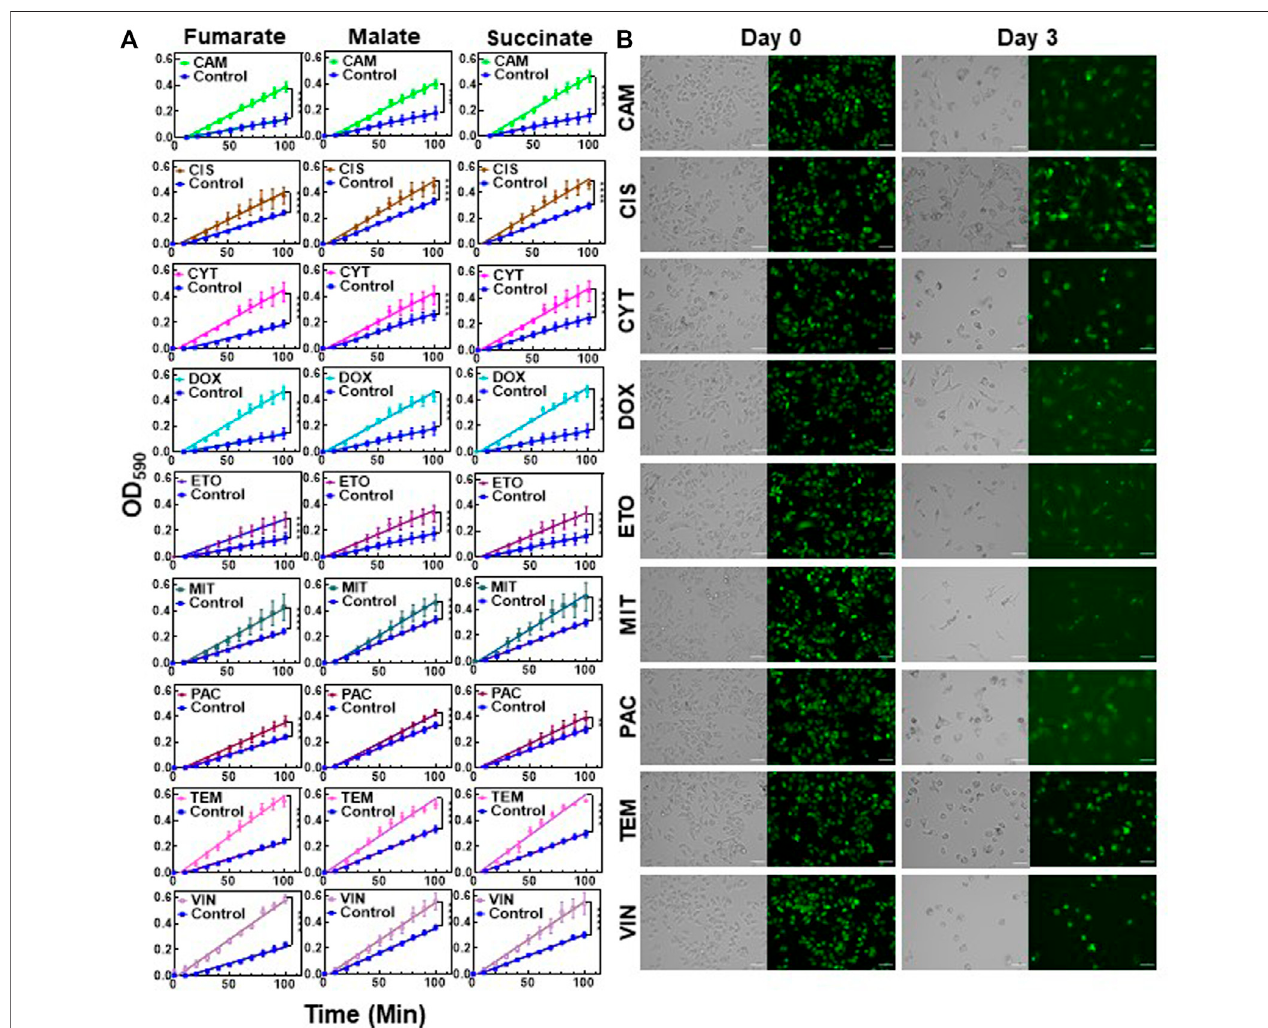
FIGURE 4 | Chemotherapeutic treatments induced slow growth and enhanced Krebs cycle activity: (A) Melanoma A375 cells were treated with the indicated chemotherapeutic agents for 3 days. After treatments, the cells were transferred to fresh medium and cultured for 24. h. Then, the cells were collected for modi fi ed MitoPlate assays to measure the consumption rates of Krebs cycle substrates. The concentrations of chemotherapeutic agents were 10xIC 50 , except TEM, whose concentration was 5xIC 50 ( Supplementary Table S2 ). Linear regression analysis was performed using F statistics (**** p < 0.0001). N (cid:1) 4. (B) Melanoma cells stainedwithCFSEweretreatedwiththeindicatedagents for3 days asdescribed above. Priortotreatment(day0) andafter treatment(day3), thegreen fl uorescenceof the cells was monitored by fl orescence microscopy. Scale bar: 100